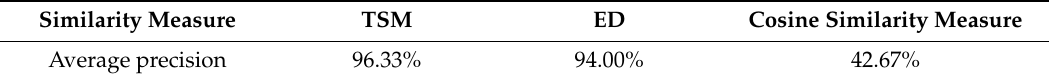
Table 5. The average precision of TSM, ED, and cosine similarity